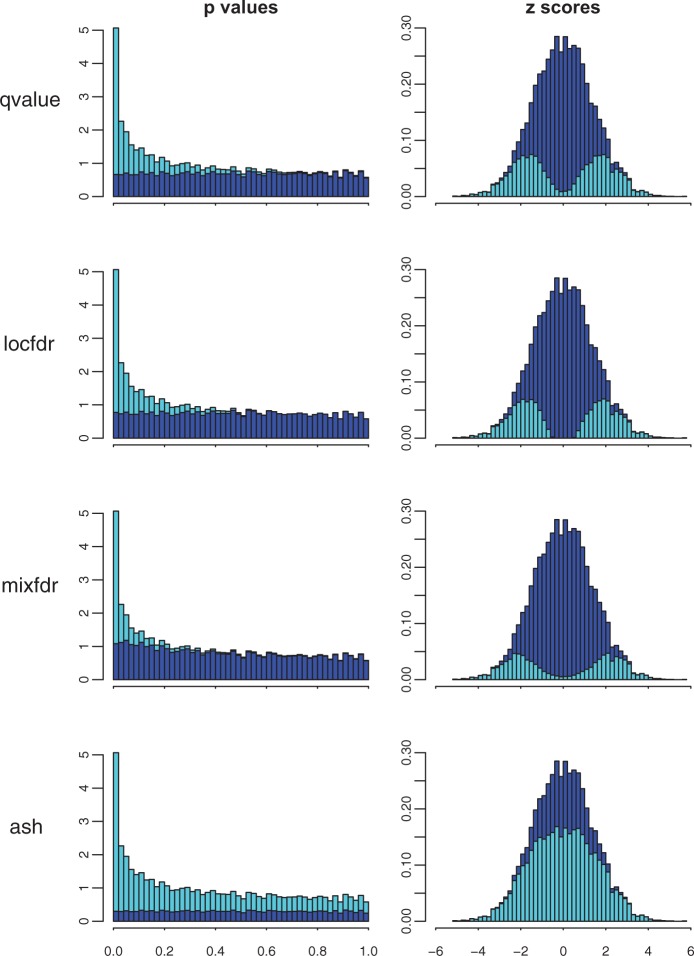
Illustration that the UA in ash can produce very different results from existing methods. The figure shows, for a single simulated dataset, the way different methods decompose \documentclass[12pt]{minimal}
\usepackage{amsmath}
\usepackage{wasysym}
\usepackage{amsfonts}
\usepackage{amssymb}
\usepackage{amsbsy}
\usepackage{upgreek}
\usepackage{mathrsfs}
\setlength{\oddsidemargin}{-69pt}
\begin{document}
}{}$p$\end{document} values (left) and \documentclass[12pt]{minimal}
\usepackage{amsmath}
\usepackage{wasysym}
\usepackage{amsfonts}
\usepackage{amssymb}
\usepackage{amsbsy}
\usepackage{upgreek}
\usepackage{mathrsfs}
\setlength{\oddsidemargin}{-69pt}
\begin{document}
}{}$z$\end{document} scores (right) into a null component (dark blue) and an alternative component (cyan). In the \documentclass[12pt]{minimal}
\usepackage{amsmath}
\usepackage{wasysym}
\usepackage{amsfonts}
\usepackage{amssymb}
\usepackage{amsbsy}
\usepackage{upgreek}
\usepackage{mathrsfs}
\setlength{\oddsidemargin}{-69pt}
\begin{document}
}{}$z$\end{document} score space the alternative distribution is placed on the bottom to highlight the differences in its shape among methods. The three existing methods (qvalue, locfdr, mixfdr) all produce a “hole” in the alternative \documentclass[12pt]{minimal}
\usepackage{amsmath}
\usepackage{wasysym}
\usepackage{amsfonts}
\usepackage{amssymb}
\usepackage{amsbsy}
\usepackage{upgreek}
\usepackage{mathrsfs}
\setlength{\oddsidemargin}{-69pt}
\begin{document}
}{}$z$\end{document} score distribution around 0. In contrast ash makes the UA—that the effect sizes, and thus the \documentclass[12pt]{minimal}
\usepackage{amsmath}
\usepackage{wasysym}
\usepackage{amsfonts}
\usepackage{amssymb}
\usepackage{amsbsy}
\usepackage{upgreek}
\usepackage{mathrsfs}
\setlength{\oddsidemargin}{-69pt}
\begin{document}
}{}$z$\end{document} scores, have a unimodal distribution about 0—which yields a very different decomposition. (In this case the ash decomposition is closer to the truth: the data were simulated under a model where all of the effects are non-zero, so the “true” decomposition would make everything cyan.)